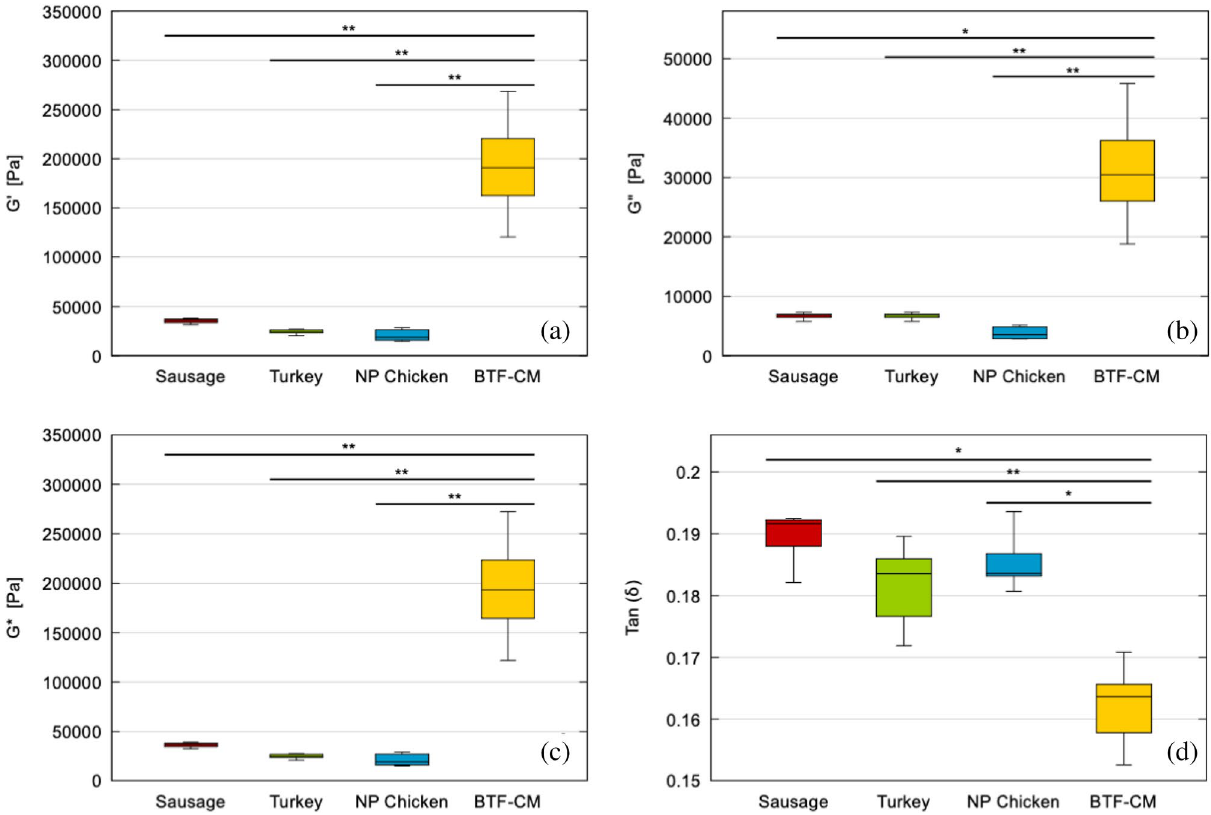
Figure 5. Box plot of (a) storage modulus (G’), (b) loss modulus (G”), (c) complex shear modulus G* and (d) tan (δ) of the three meat references and the cultured meat (p values < 0.01 *; < 0.001 **; < 0.0001